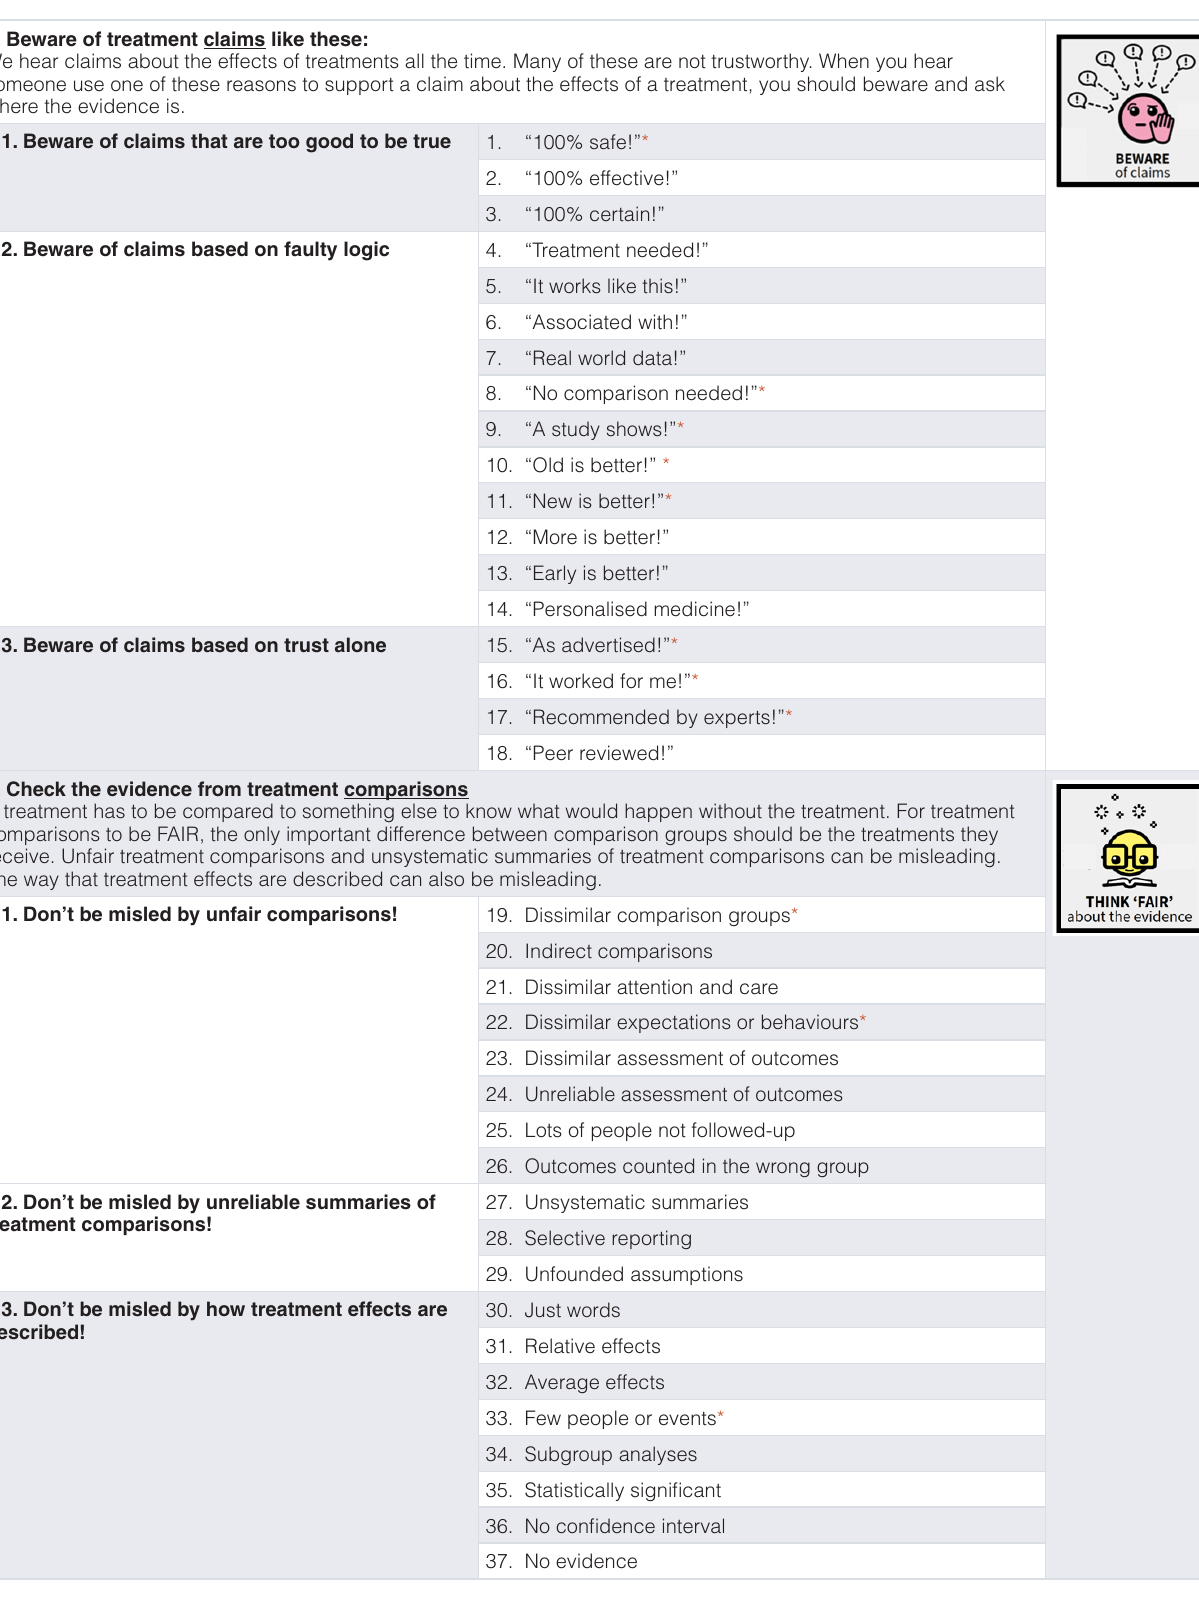
Table 1. List of key concepts from the Informed Health Choices project 13